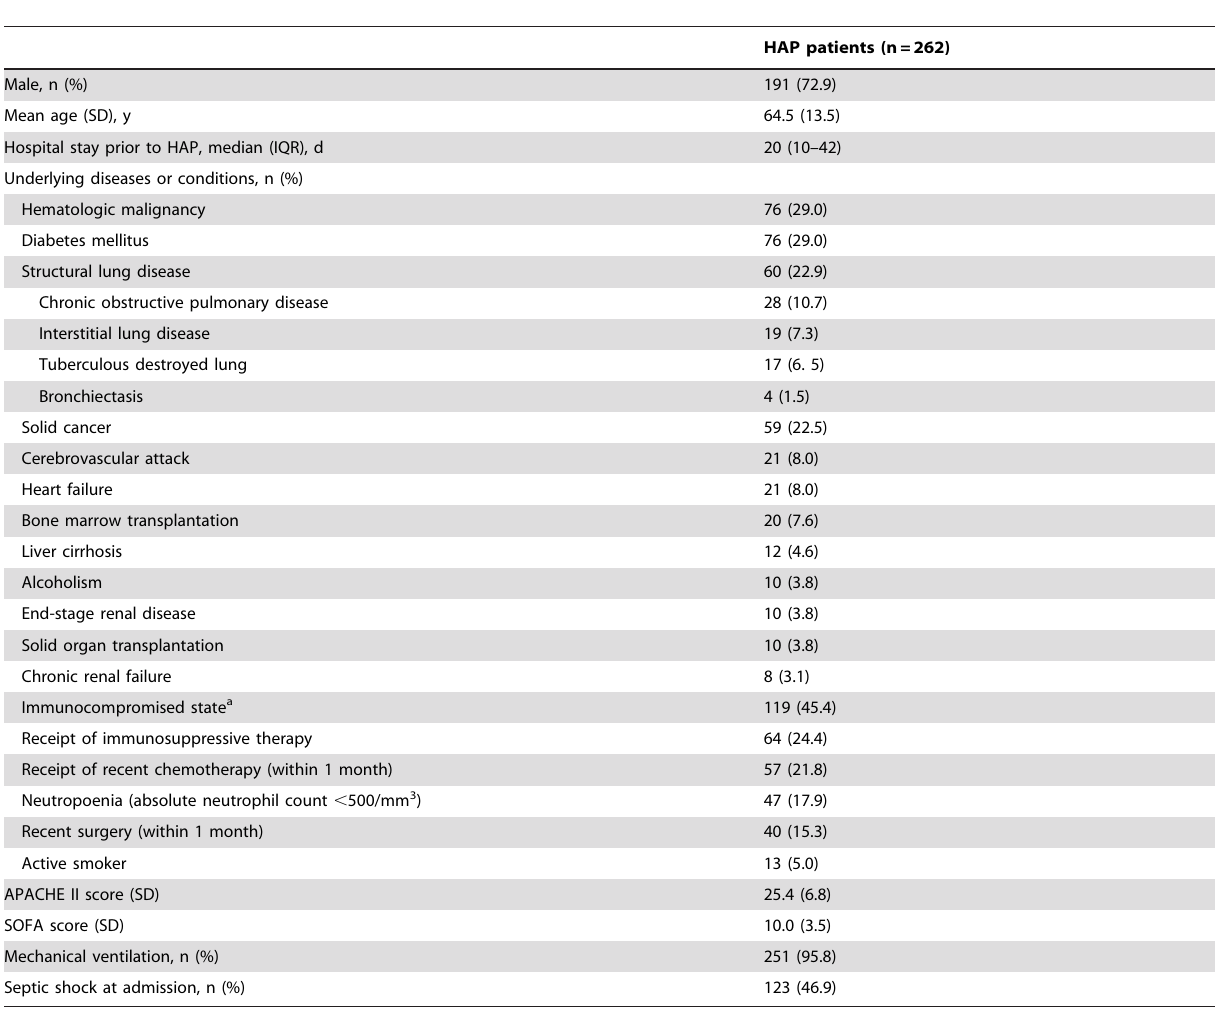
Table 1. Demographics, underlying disease/condition, and clinical characteristics of patients with severe hospital-acquired